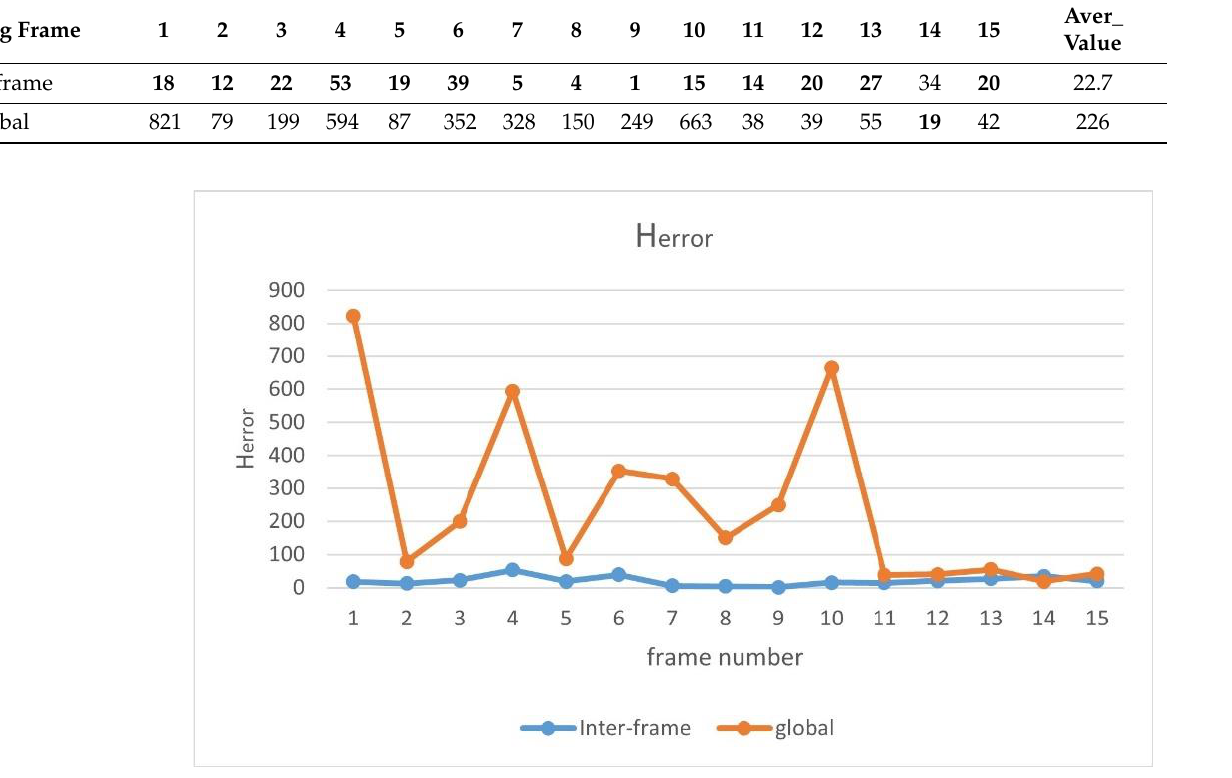
Figure 16. Comparison of the inter-frame and global 𝐻 𝑒𝑟𝑟𝑜𝑟 values.